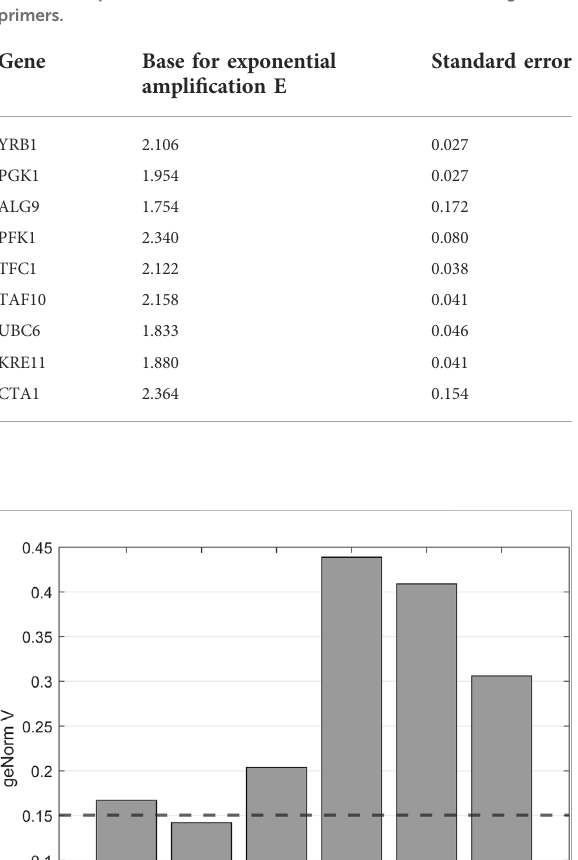
FIGURE 3 geNorm V analysis for optimal reference gene number determination. Pairwise variation was used to determine the minimum number of reference genes for normalization. AccordingtoVandesompeleetal.(2002)variationsbelowthe cut-offvalueof0.15,displayedasadashedhorizontalline,indicate no signi fi cant contribution of an additional control gene to the normalization factor.